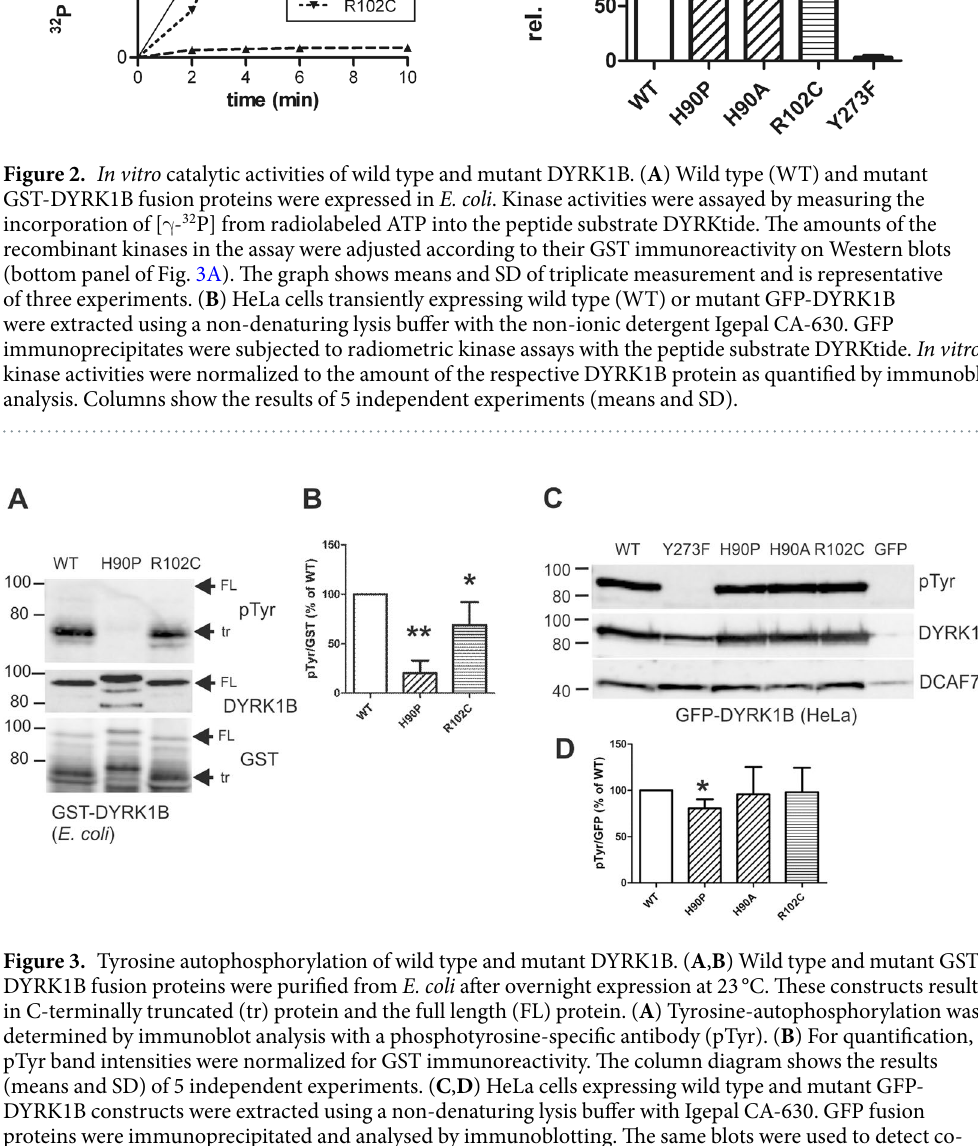
box and does not allow definitive conclusions regarding the effects of the missense mutations on the function of the kinase. In vitro -kinase activity of the pathogenic DYRK1B point mutants.